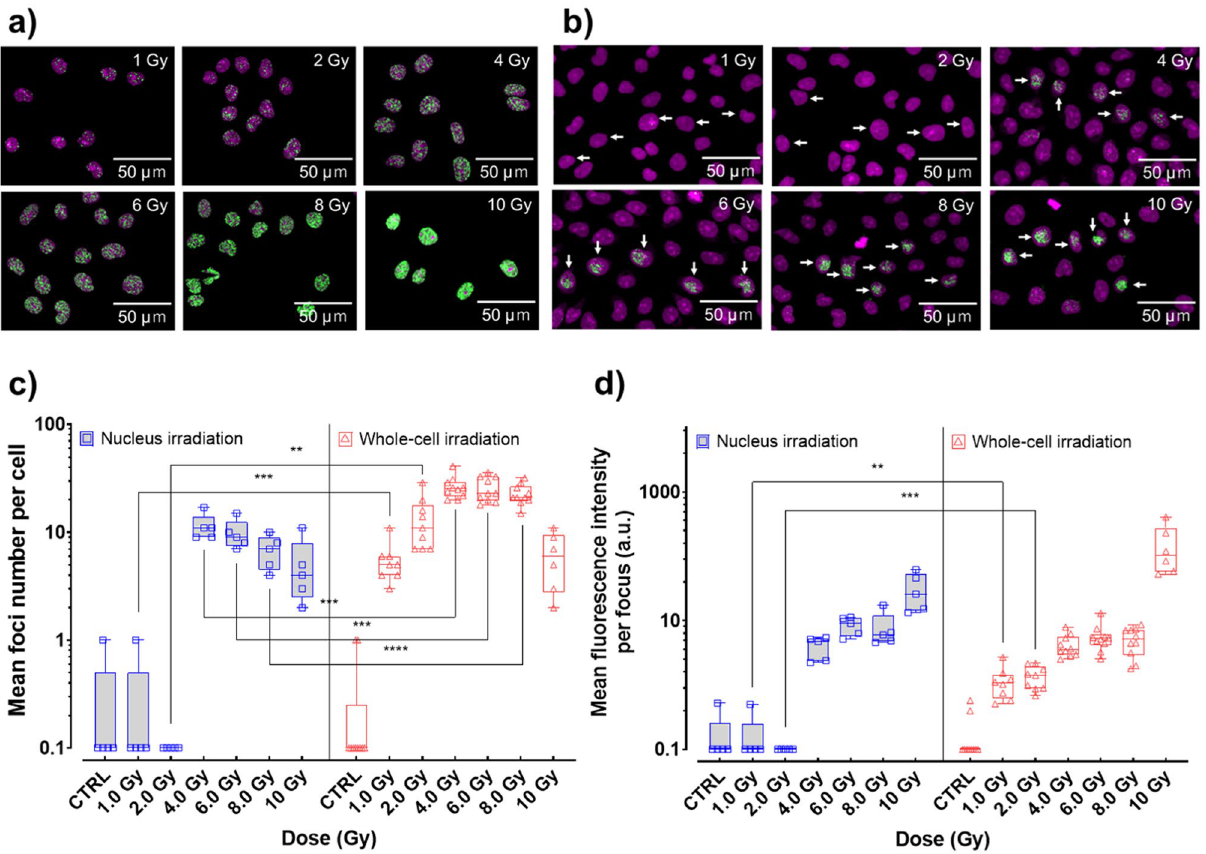
Figure 3. Accumulation of phosphorylated histone H2AX (γ-H2AX) foci in V79 cells after 30 min of nucleus or whole-cell irradiation. γ-H2AX foci formation following the irradiation of V79 whole cells ( a ) or V79 nuclei ( b ). White arrows in ( b ) identify irradiated cells. Propidium iodide staining and γ-H2AX foci in the captured images are presented as magenta and green signals, respectively. During imaging analysis, the mean foci number in irradiated V79 cells ( c ) and the mean fluorescence intensity at a focus in V79 cells ( d ) was measured using Image-Pro Plus 7.0. CTRL, nonirradiated control cells. To make a quantitative comparison, analysis was performed using images acquired under the same condition in the same batch of experiments. Results are shown by box-and-whisker plots with individual data points. The boxes indicate the 25–75th percentile, the line in the boxes indicates the median, and the whiskers indicate the range (minimum to maximum) of the data. p-values ( ns not significant, *p < 0.05, **p < 0.01, ***p < 0.001, ****p < 0.0001) in ( c ) and ( d ) calculated by Student’s t test. p-values for each comparison pair are also shown in Supplementary Tables S3 and S4